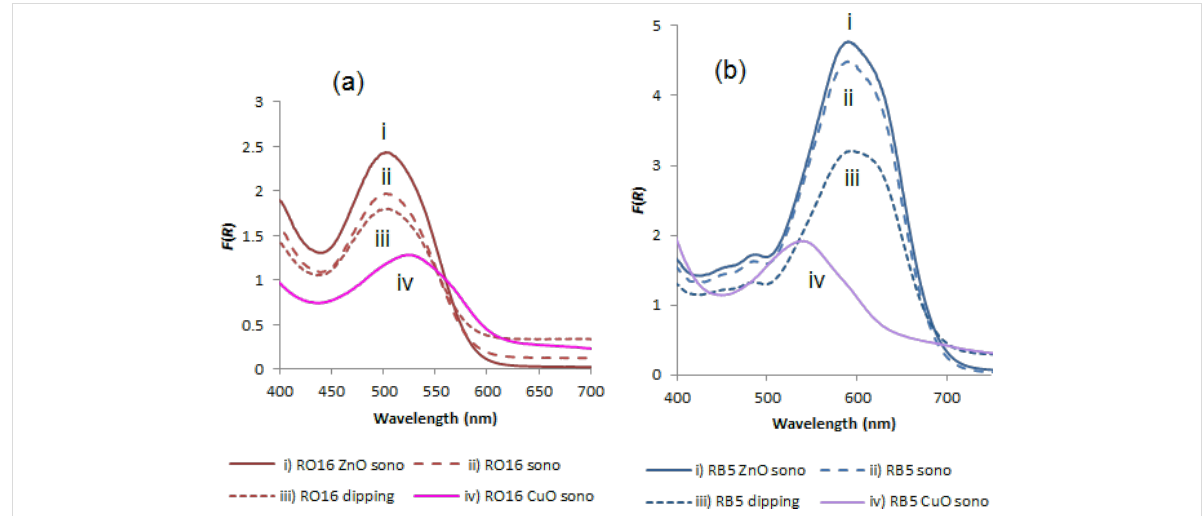
Figure 3: Absorption measurements in the visible region of the colored bandages coated with dyes RO16 (a) or RB5 (b) and ZnO or CuO NPs: (i) bandages coated with corresponding dyes and ZnO NPs by the sonochemical method; (ii) bandages coated with only dyes by sonochemical method; (iii) bandages coated with only dyes by dipping procedure; (iv) bandages coated with CuO NPs by the sonochemical method.